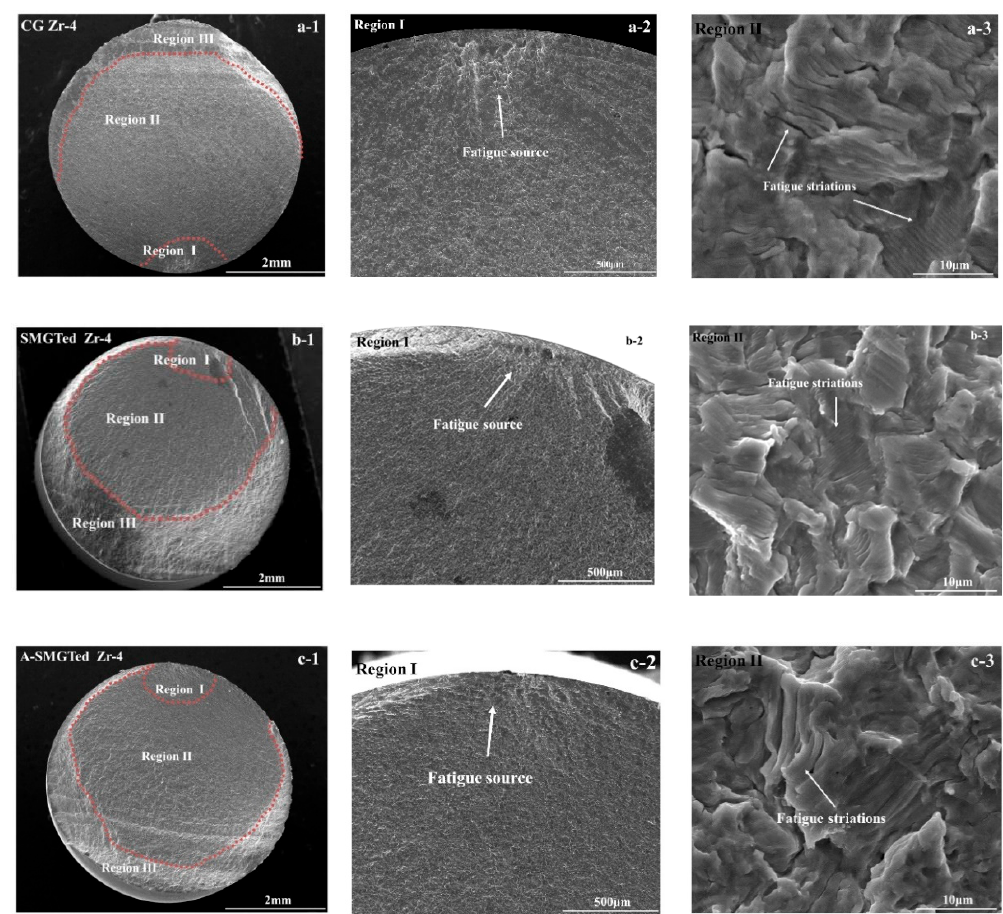
Figure 7. Fatigue fracture of CG, SMGTed, and A-SMGTed Zr-4 samples, ( a-1 , b-1 , c-1 ) macroscopic fracture morphology of fatigue samples ( a-2 , b-2 , c-2 ): fatigue crack source; ( a-3 , b-3 , c-3 ): morphology of fatigue crack propagation region.